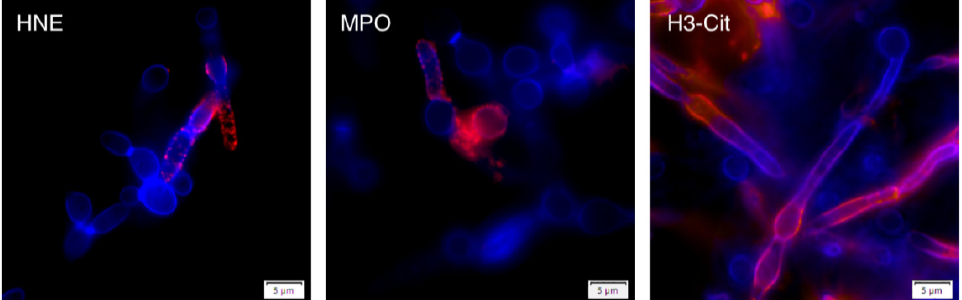
Figure 2. The localization of NET proteins on the hyphal forms of C. albicans cells after the DNA scaffold removal. Neutrophils (5 × 10 4 cells) were incubated with C. albicans (10 6 cells) for 3 h at 37 °C. After stimulation, the released NETs were degraded by DNase I (5 U/100 µL). The yeast-bound neutrophil proteins were identified using the rabbit primary antibodies anti-HNE, anti-MPO, and mouse anti-histone H3 or anti-citrullinated histone H3 (1:100), and then secondary Alexa Fluor 555-labeled antibodies (1:300). The C. albicans cell wall was stained with Calcofluor White dye (blue). A representative result of three experiments is presented. The presence of HNE, MPO and citrullinated histone H3 on the surface of C. albicans was visualized with a Olympus IX73 fluorescence microscope (60 × magnification).